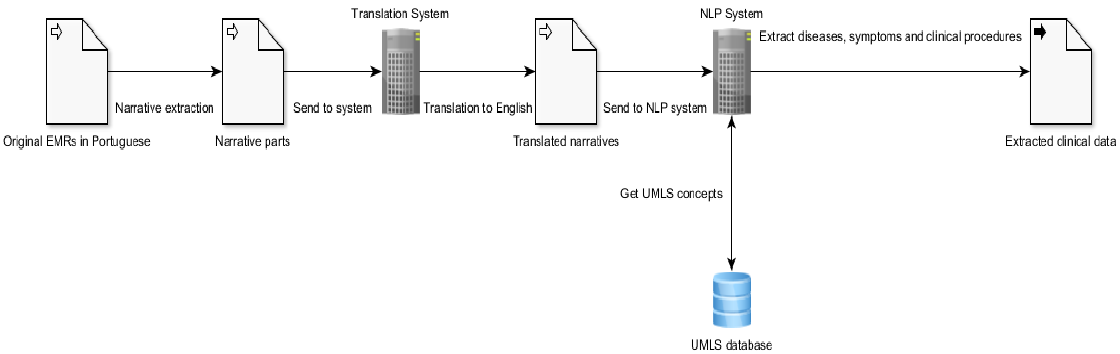
Figure 2. A high-level view of the whole pipeline system.